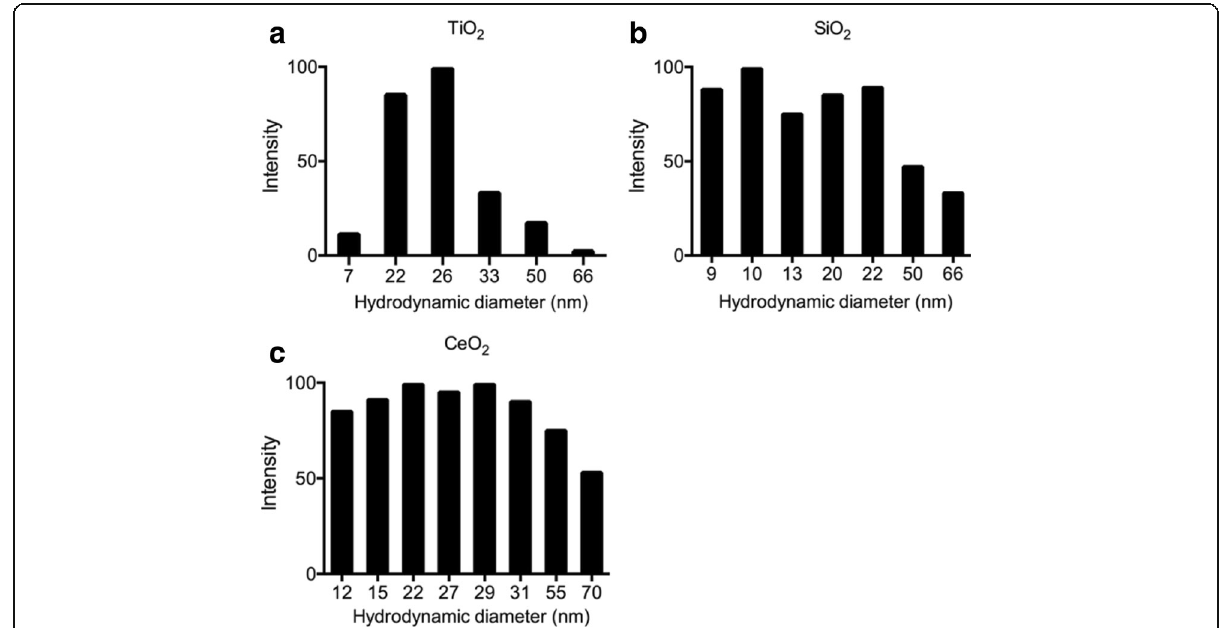
Fig. 1 ENP characterization by DLS assessment of a TiO 2 , b SiO 2 , and c CeO 2 in L1 medium after sonication showing their size distribution. The ENP final concentration in DLS sample is 1 μ g/ml, the measuring time is 3 min right after the